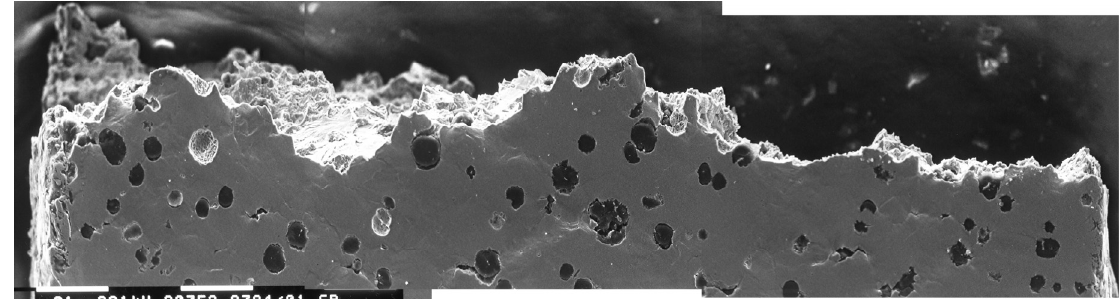
Figure 9: SEM lateral observation of the fracture surface (central notch radious, R = 12.5 mm)